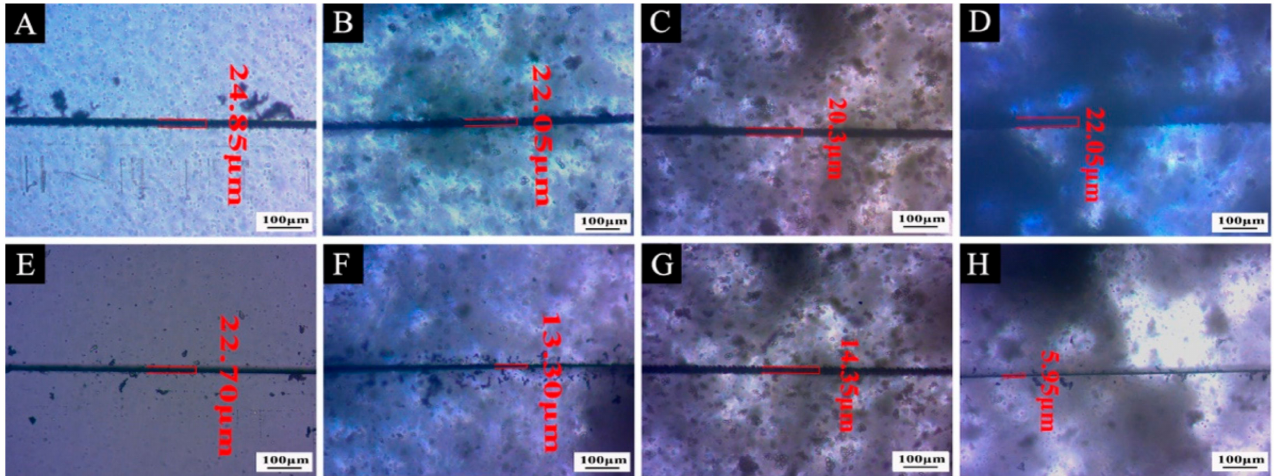
Figure 10. OM of scratch test of waterborne films with shellac microcapsules: ( A ) damaged pure waterborne coating, ( B ) damaged waterborne coating containing transparent shellac microcapsules, ( C ) damaged waterborne coating containing purple shellac microcapsules and ( D ) damaged water- borne coating containing yellow shellac microcapsules before self-repairing for 5 days; ( E ) damaged pure waterborne coating, ( F ) damaged waterborne coating containing transparent shellac microcap- sules, ( G ) damaged waterborne coating containing purple shellac microcapsules and ( H ) damaged waterborne coating containing yellow shellac microcapsules after self-repairing for 5